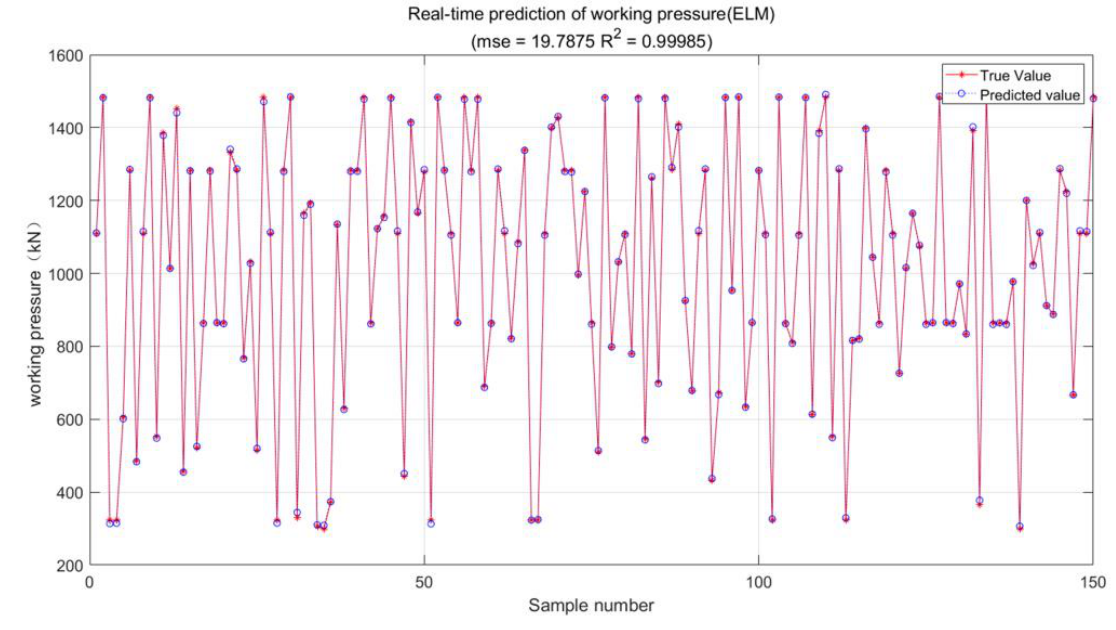
Figure 8. Real-time prediction of the working pressure.